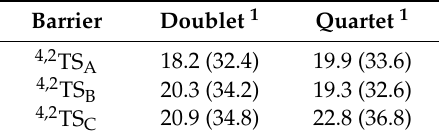
Table 1. Calculated rate determining barrier heights for various oxidation